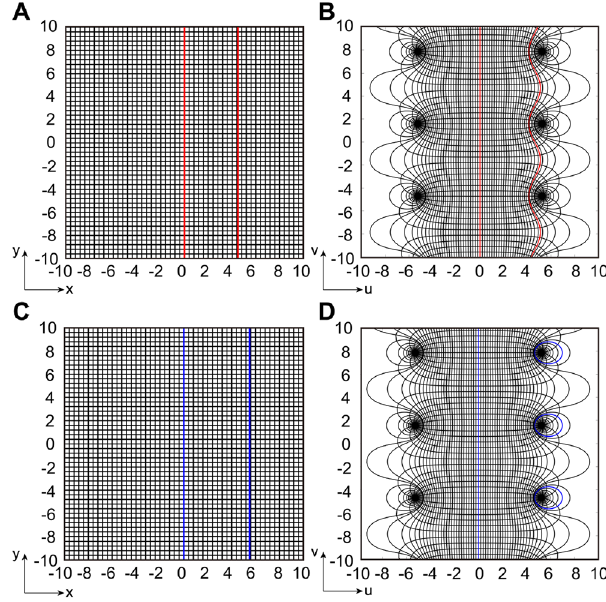
Figure 1: Schematic diagram of the conformal transformation. (A) The slab (areabetween red straight lines) in the virtual space can be transformed into (B) the periodic grating (area between the red straight line and the red curve) in the physical space. The parameters were y 0 = 0.005, w 0 = 0.005, d = 4.5, γ = 1. (C) The slab (area between blue straight lines) in the virtual space can be transformed into (D) the periodic grating (area between the blue straightlineandtheseveralblueellipses)inthephysicalspace.The parameters were y 0 = 0.005, w 0 = 0.005, d = 5.5, γ =